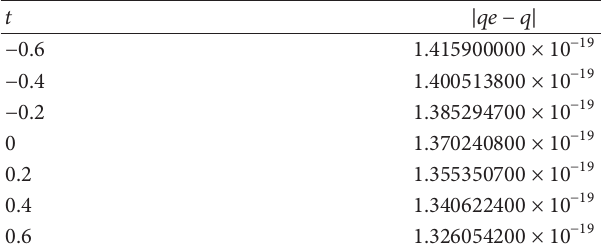
Table 3: The HAM results for 𝑞 (𝑥,𝑦,𝑡) in comparison with the analytical solution with initial conditions